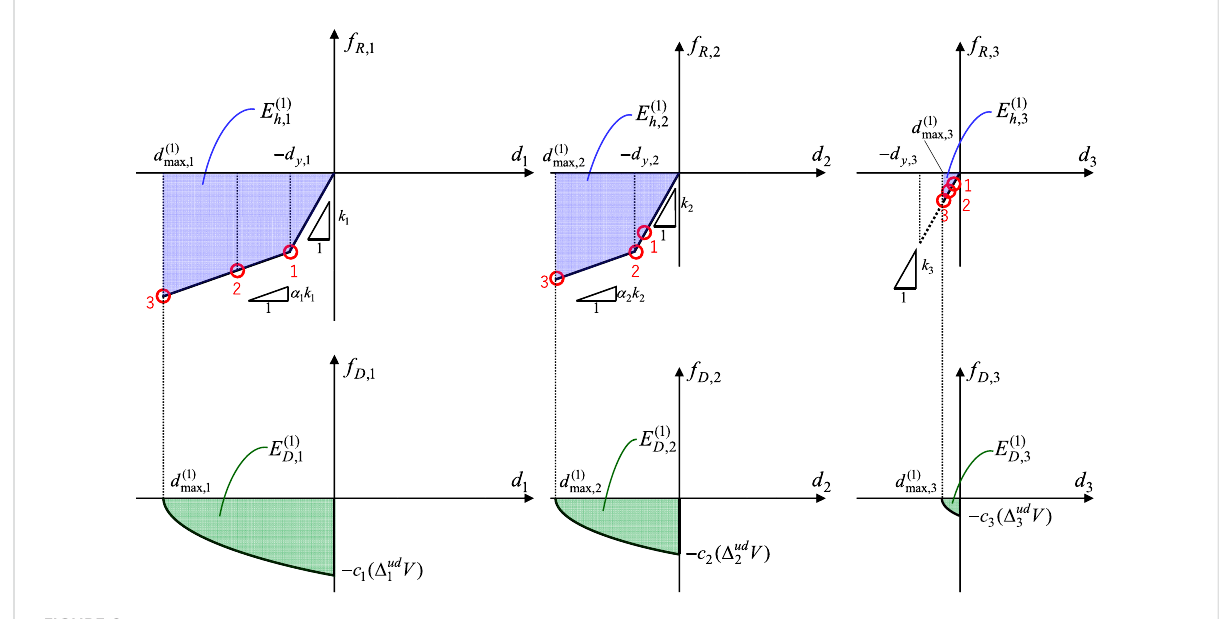
FIGURE 8 Evaluation of maximum interstory drifts d ( 1 ) max after the fi rst